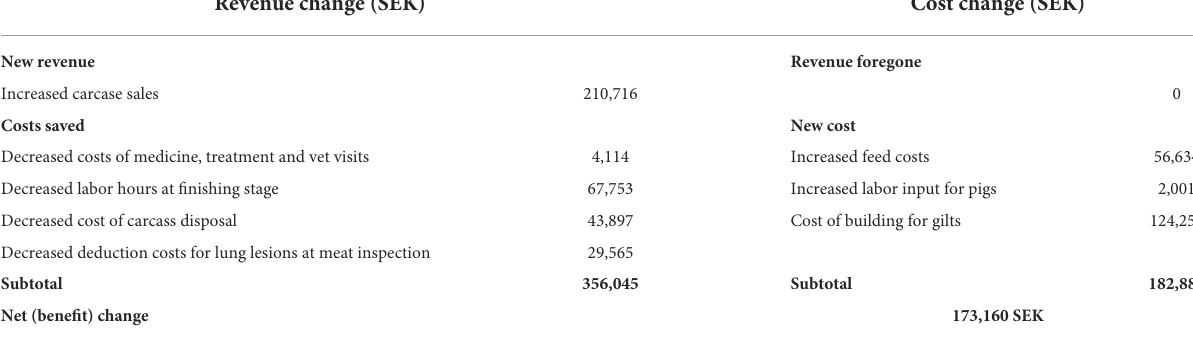
TABLE 7 Deterministic effects on net benefit change of adopting strategy S2 (keeping purchased gilts